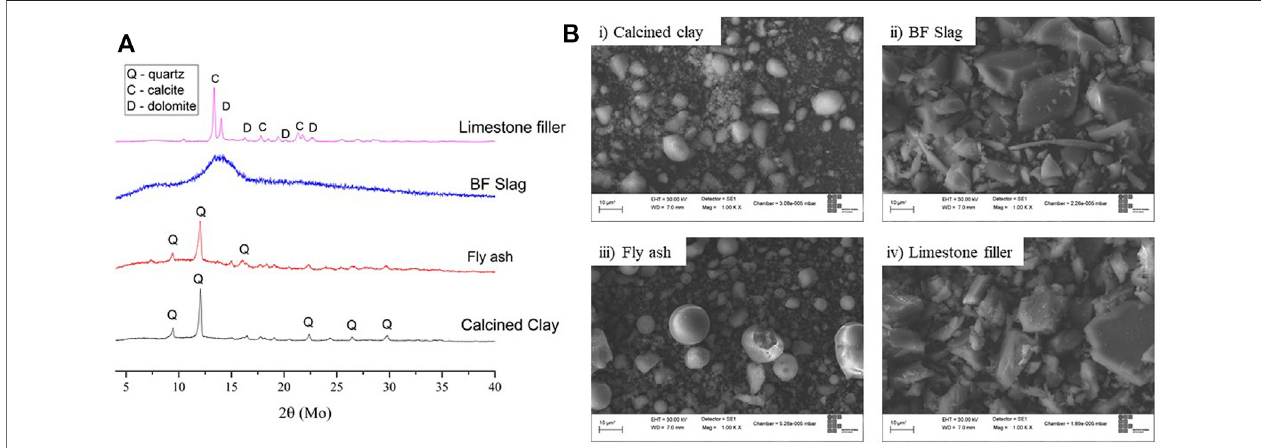
FIGURE 2 | (A) XRD analyses and (B) Particle morphology.